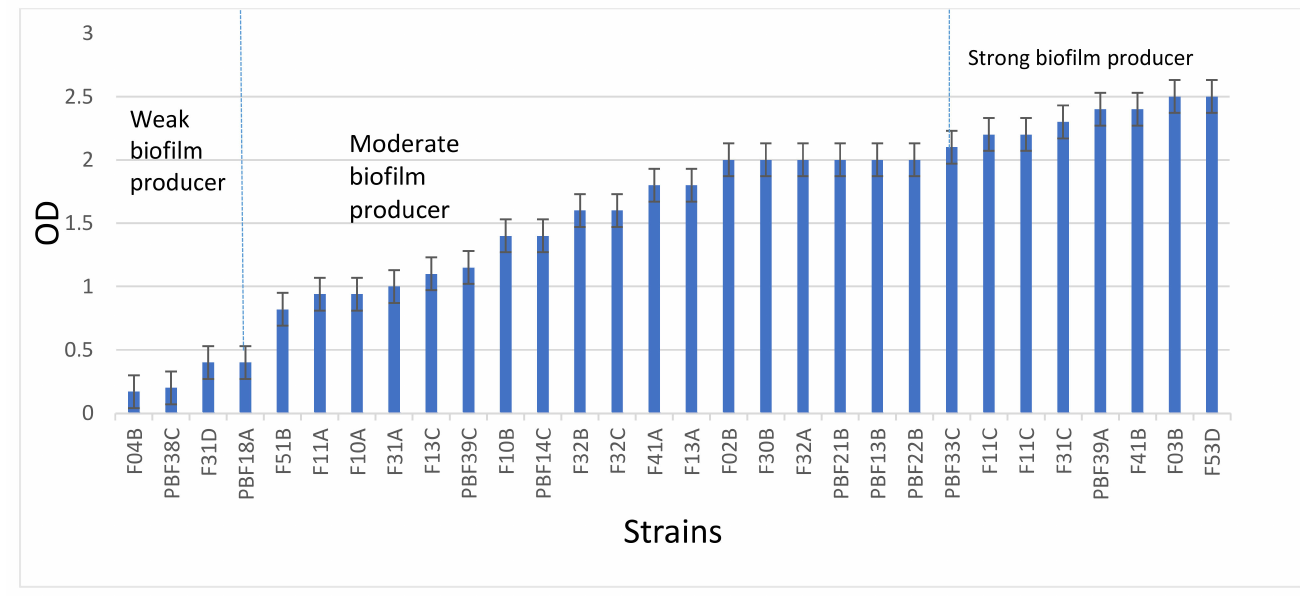
Figure 2. Biofilm formation of S. aureus isolates. Based on OD reader the biofilm was classified into 3 categories: strong (OD550 > 2.0), moderate (2.0 > OD550 > 0.4), weak (0.4 > OD550 > 0.1), or negative (OD550 < 0.1). OD 0.1 was set as a cut-off point to distinguish between biofilm producer and non-biofilm producer. Error bars represent standard deviation of